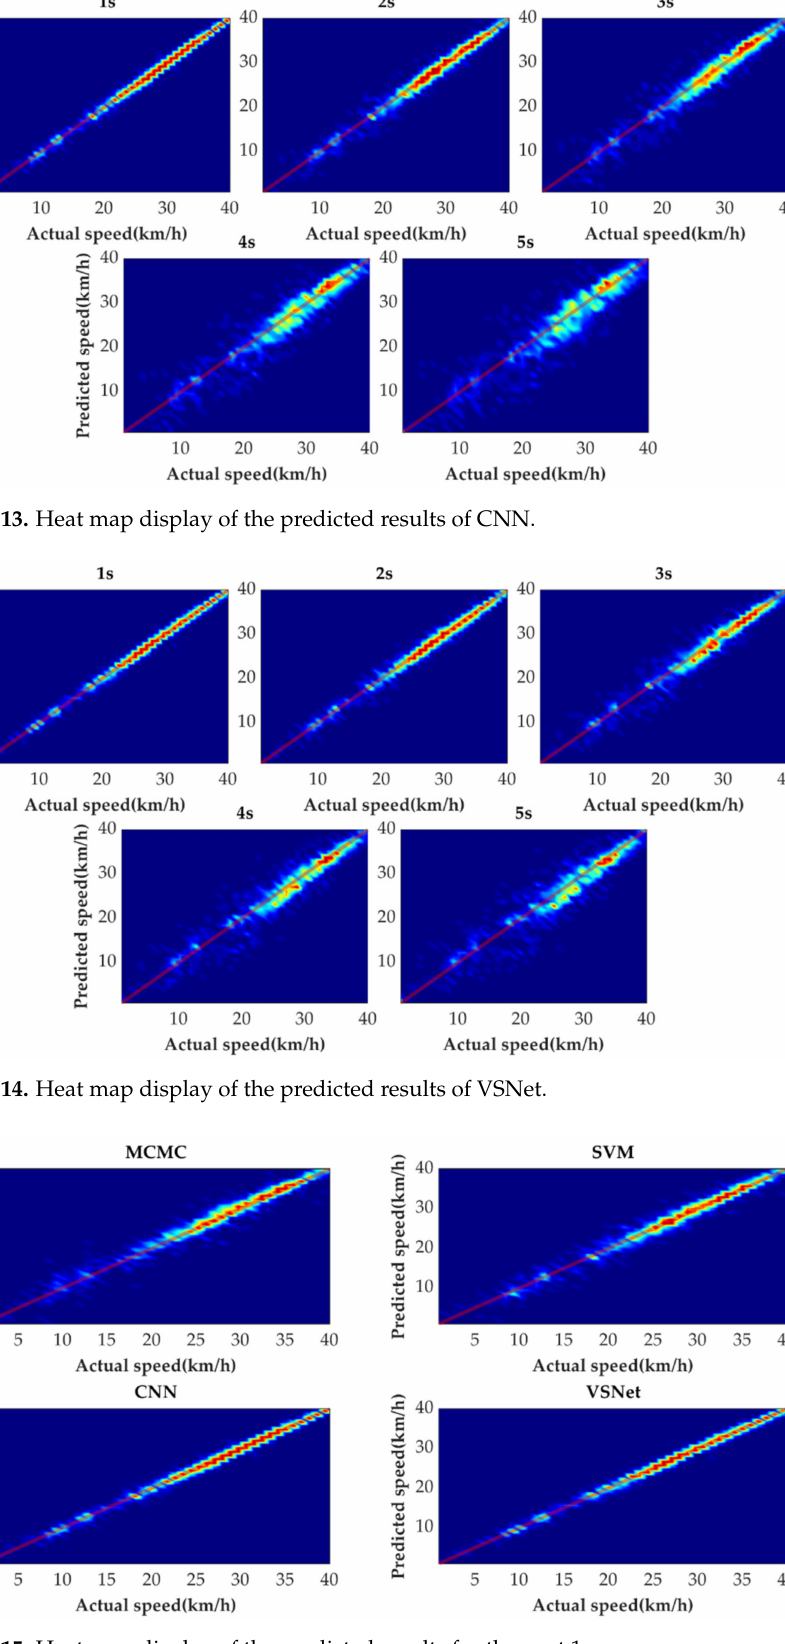
Figure 15. Heat map display of the predicted results for the next 1